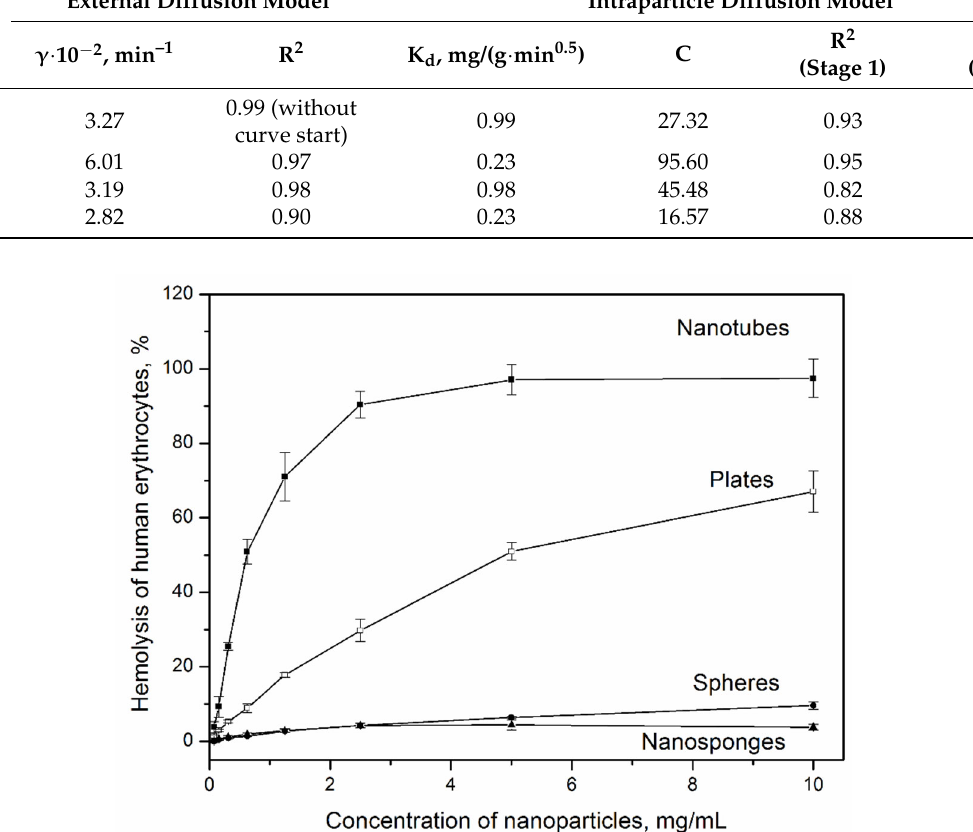
Figure 10. The hemolytic activity of the particles with different morphology.